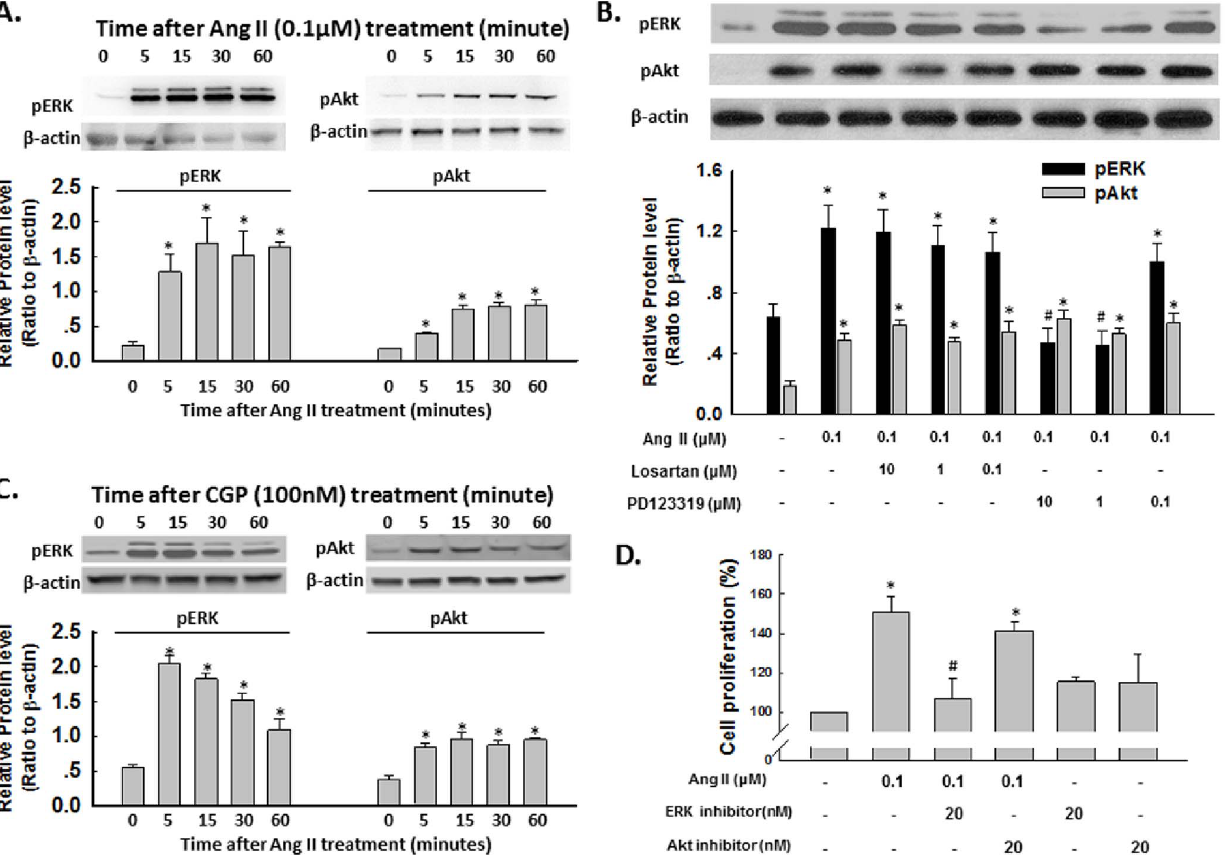
Figure 3. Ang II -induced ERK and Akt activation. A) Representative blots (upper panel) and mean data of relative blot density (lower panel) showing Ang II induced a rapid phosphorylation of ERK and Akt in NSCs. Cells were treated with Ang II for different time followed by western- blot analysis. *P , 0.05 vs untreated group; n=3 in each group. B) Representative blots (upper panel) and mean data of blot density (lower panel) showing blockade of AT1R and AT2R on phosphorylation of ERK and Akt. NSCs were pre-treated with specific antagonist to AT1R or AT2R for 1 hour followed by incubation with Ang II for 30 min. *P , 0.05 vs untreated group, # P , 0.05 vs Ang II-treated group; n=3 in each group. C) Representative blots (upper panel) and mean data of relative blot density (lower panel) showing CGP42112A induced a rapid phosphorylation of ERK and Akt in NSCs. Cells were treated with CGP42112A for different time followed by western-blot analysis. *P , 0.05 vs untreated group; n=3 in each group. D) Effect of blockade of ERK and Akt on Ang II-induced NSC proliferation. Cells were pretreated with specific ERK or Akt pathway inhibitor-U0126 or